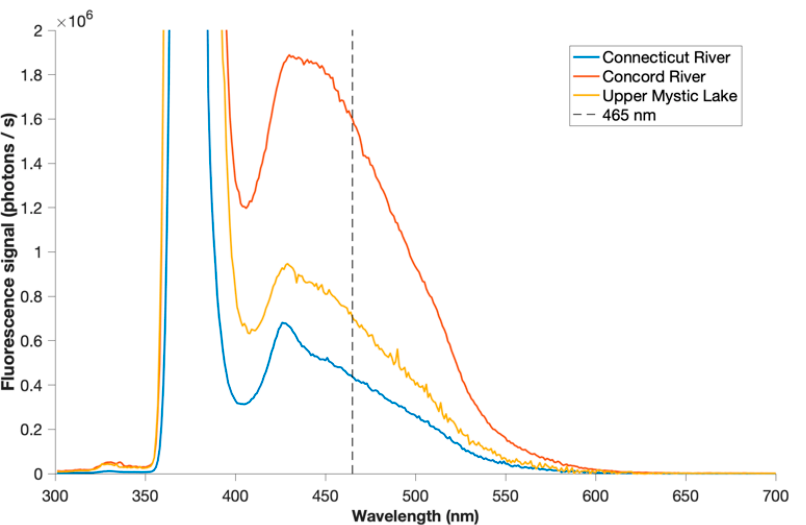
Figure 5. Fluorescence emission spectra measured by FACT sensor at all three sites, including LED excitation scattering at 375 nm. Emission was measured at 465 nm for eddy covariance trials.